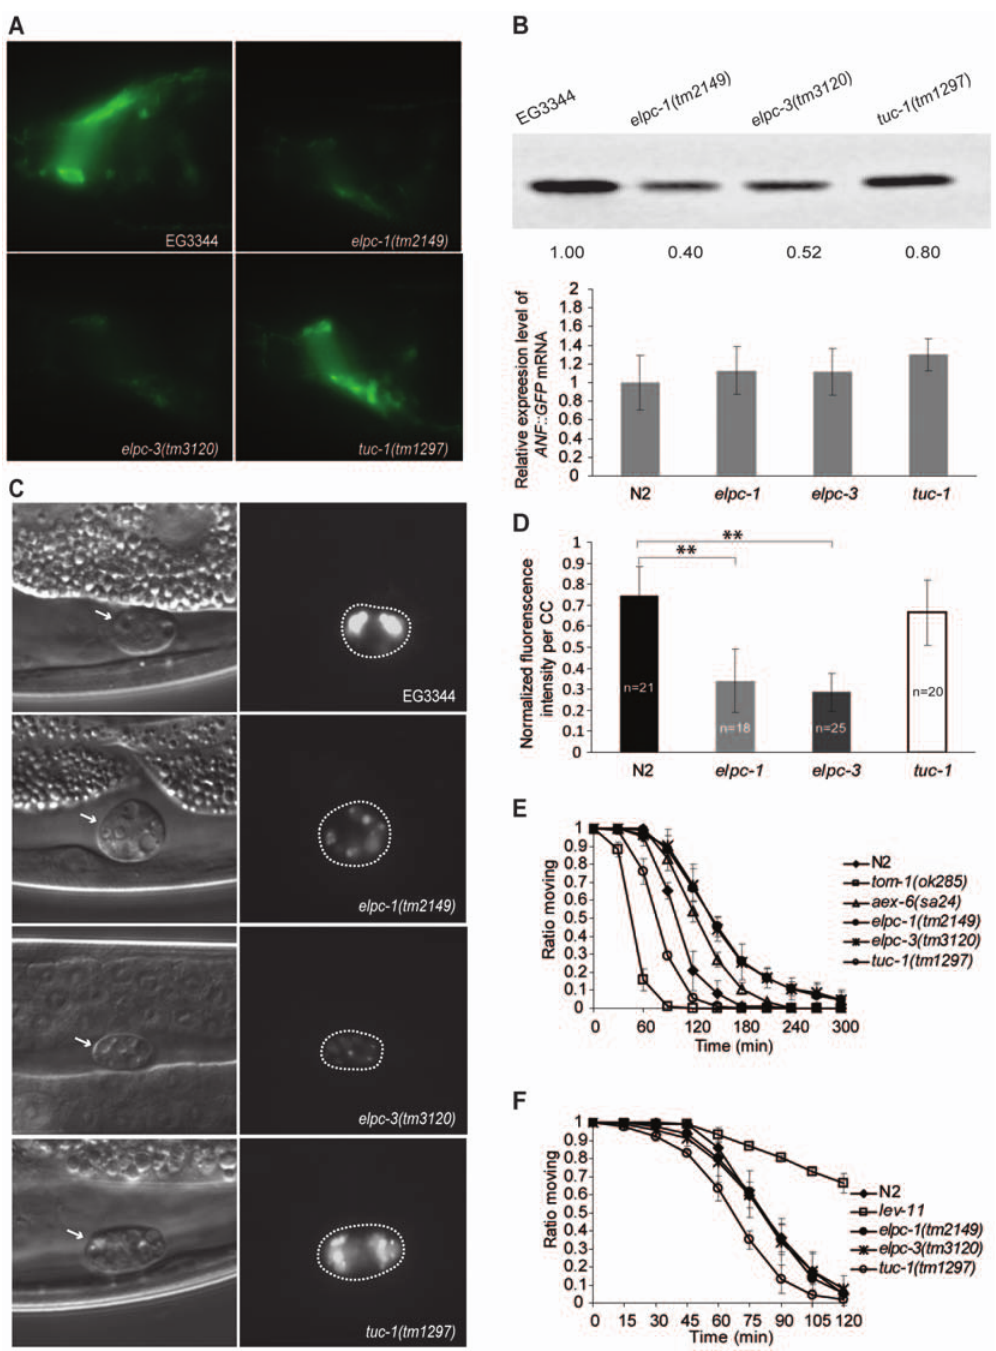
Figure 6. Neurons in the elpc-1 ( tm2149 ) and elpc-3 ( tm3120 ) mutants show reduced production of neuropeptide. (A) Fluorescence micrographs showing the nerve ring in worms harboring a transgene encoding ANF::GFP. (B) At top, western blot of protein extracts from worms of the indicated genotypes that contained the ANF::GFP transgene. The same amount of protein was loaded in each lane. The blot was probed with an antibody against GFP. Below, ANF::GFP transcripts were quantified by Real-time PCR. No significant difference was observed in the levels of ANF::GFP mRNA (Student’s t test, p . 0.05), which were normalized to tbb-2 mRNA. (C) Micrographs showing coelomocytes in worms carrying the ANF::GFP transgene. Those on the left were viewed with DIC optics. Those on the right are of the same worms viewed with fluorescence optics. Dashed lines indicate the locations of the coelomocytes. Note that the intensity of GFP fluorescence in EG3344 and tuc-1(tm1297) coelomocytes is higher than that in elpc-1 ( tm2149 ) and elpc-3 ( tm3120 ) mutant worms. (D) Graph showing the normalized pixel intensities of confocal images of coelomocytes (CC). The number of coelomocytes measured for each strain is shown on the bar. The strongest pixel intensity per coelomocyte of ANF::GFP in any worm tested was arbitrarily set to 1. Error bars represent standard deviations. Two asterisks indicate the significant difference from control worms by student’s t test (**p , 0.001). (E) Aldicarb sensitivity assays. The proportion of worms still able to move is plotted against time for the six different genotypes. N2 is the wild-type control; aex-6 ( sa24 ) is a strain previously shown to display increased resistance to aldicarb, and tom-1 ( ok285 ) is hypersensitive to aldicarb. (F) Levamisol sensitivity assays were performed in the same way as aldicarb assays. N2 is the wild-type control. lev-11 is a strain previously shown to be resistance to levamisol.